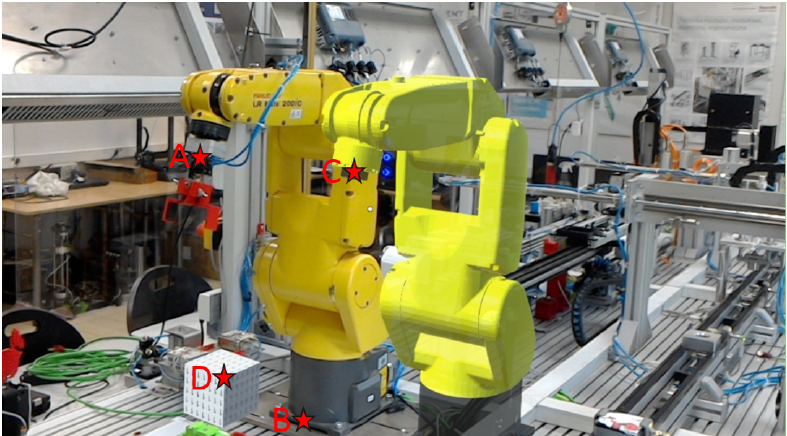
Figure 8. Real view with the digital twin of the robot superimposed, where: A—a point on the actual robot’s wrist; B—a reference point on the actual robot’s base; C—a point on the Digital Twin of the robot; D—a point on the virtual object.